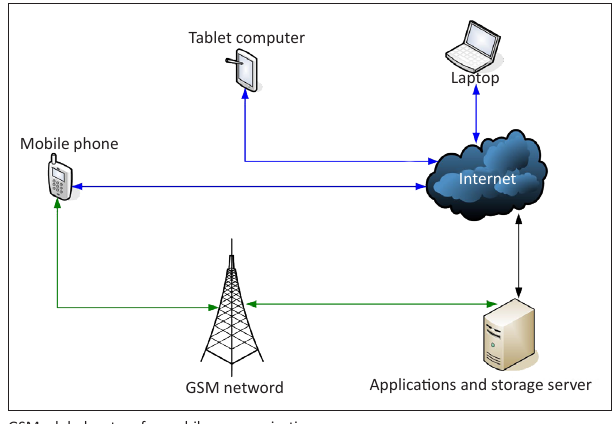
GSM, global system for mobile communications. FIGURE 3: A two-way communication system set up between server and